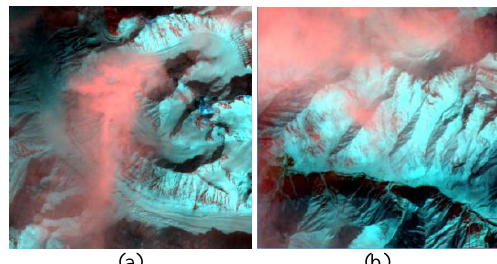
Figure 3. Tiles selected from the main image for (a) training and